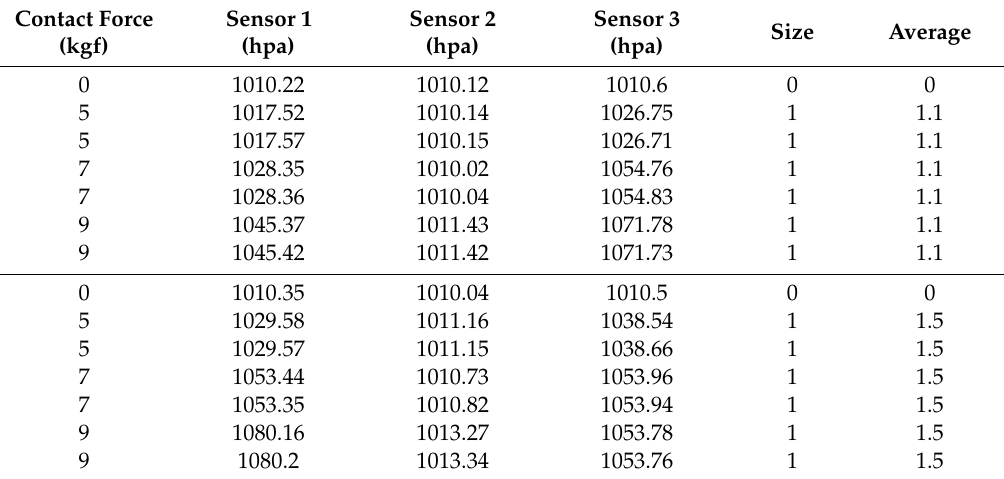
Table 2. Training data for the average the contact area.